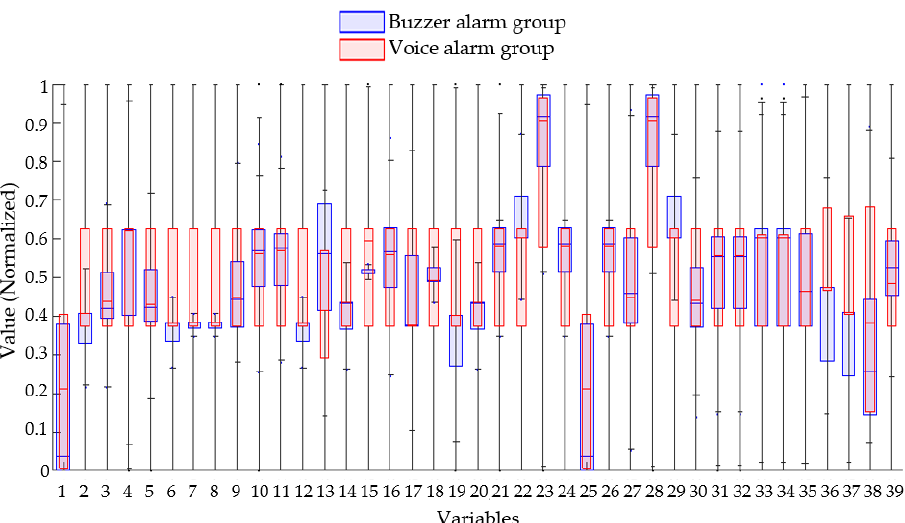
Figure 5. Box plots for each variable after preprocessing.